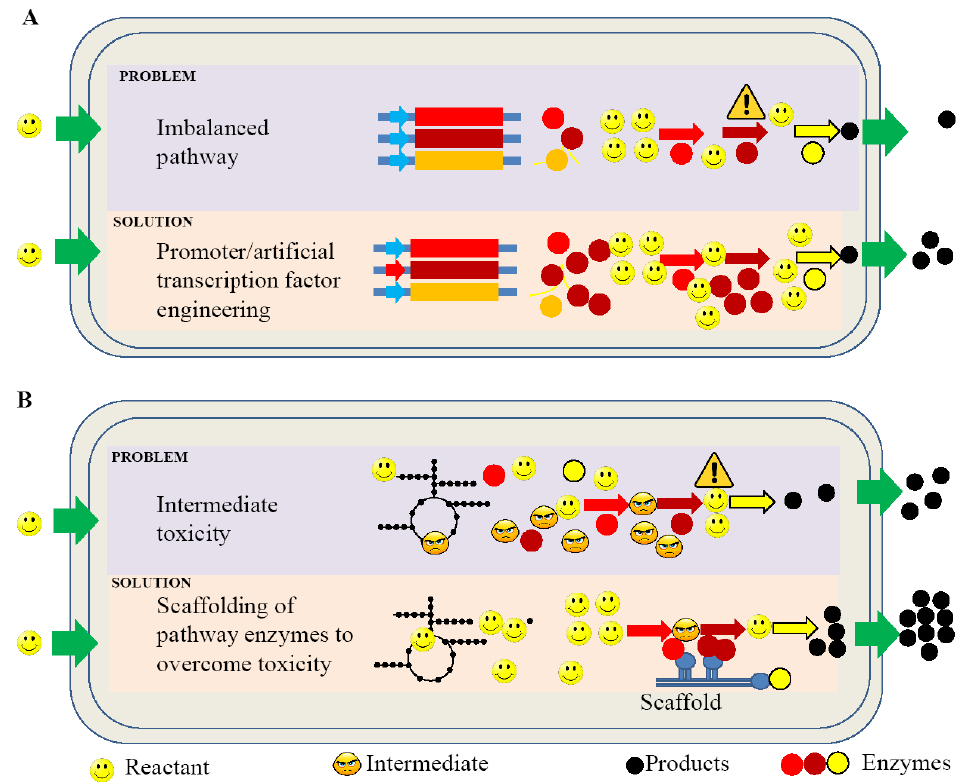
Figure 3. Graphical representation of improving bio-hydrocarbon production in bacteria. The figure shows challenges and possible solutions in transcription ( A ) and metabolite toxicity ( B ) in newly engineered strains.